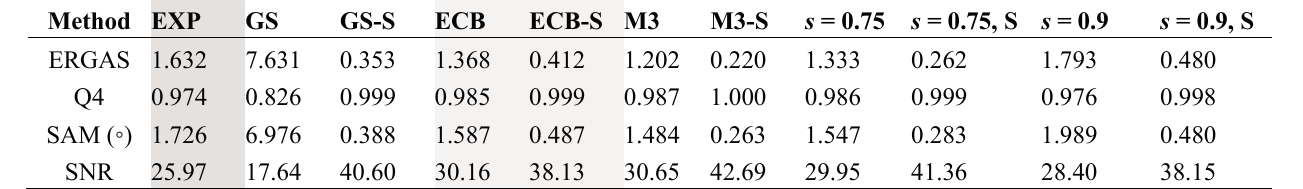
Table 11. Quantitative comparison of the fusion results after degrading the images into the LR resolution, i.e ., at 8.0 m, to check the consistency property of the Wald’s protocol for the WorldView-2 group 2 dataset at the reduced scale.